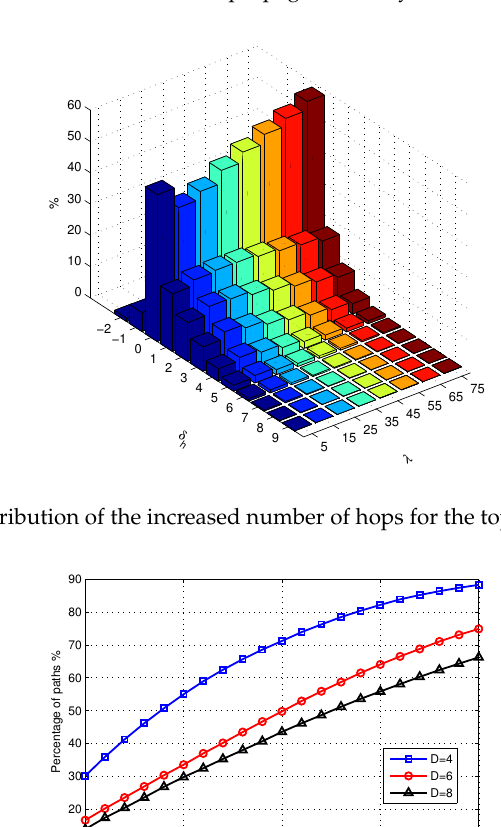
Figure 9. The distribution of the increased propagation delay for the topology set with D = 4.